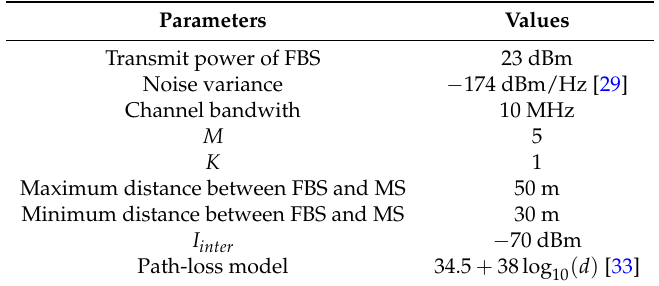
Table 1. Simulation parameters, FBS: femto-cell base stations; MS: mobile station. Parameters